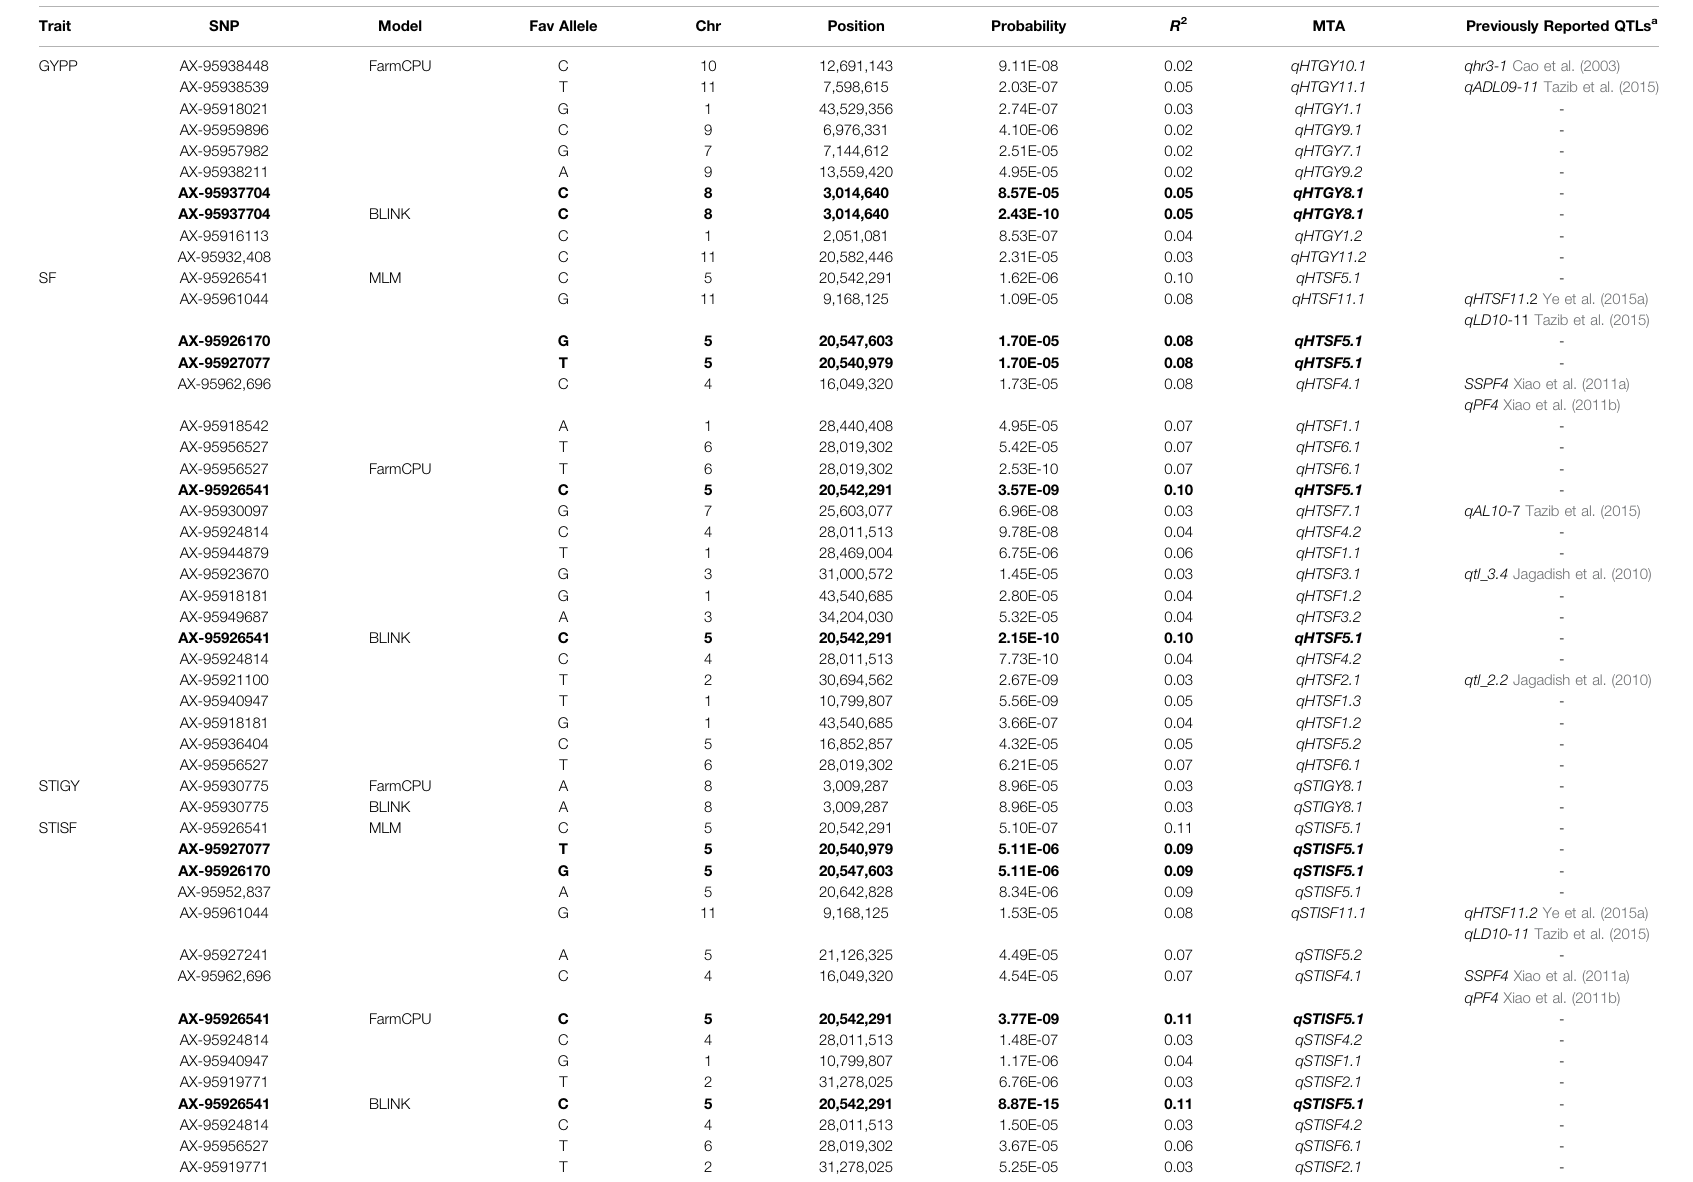
TABLE 2 | Signi fi cant MTAs identi fi ed for grain yield plant − 1 (GYPP) and spikelet fertility (SF) under heat stress and their respective stress tolerance indices. Trait SNP Model Fav Allele Chr Position Previously Reported QTLs a